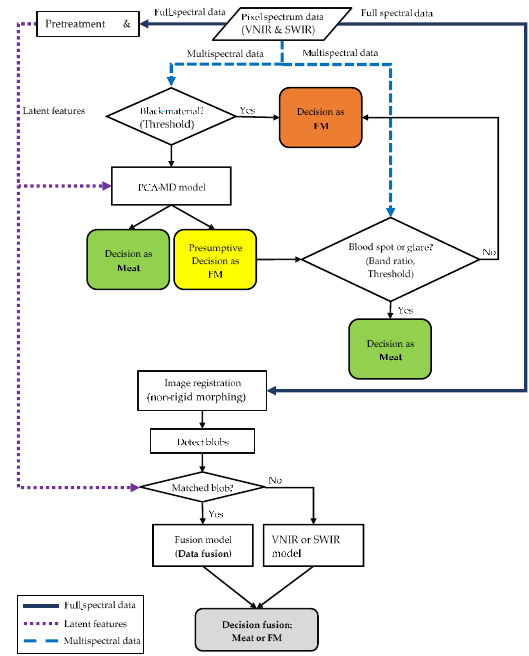
Figure 3. Flow chart of the overall classification